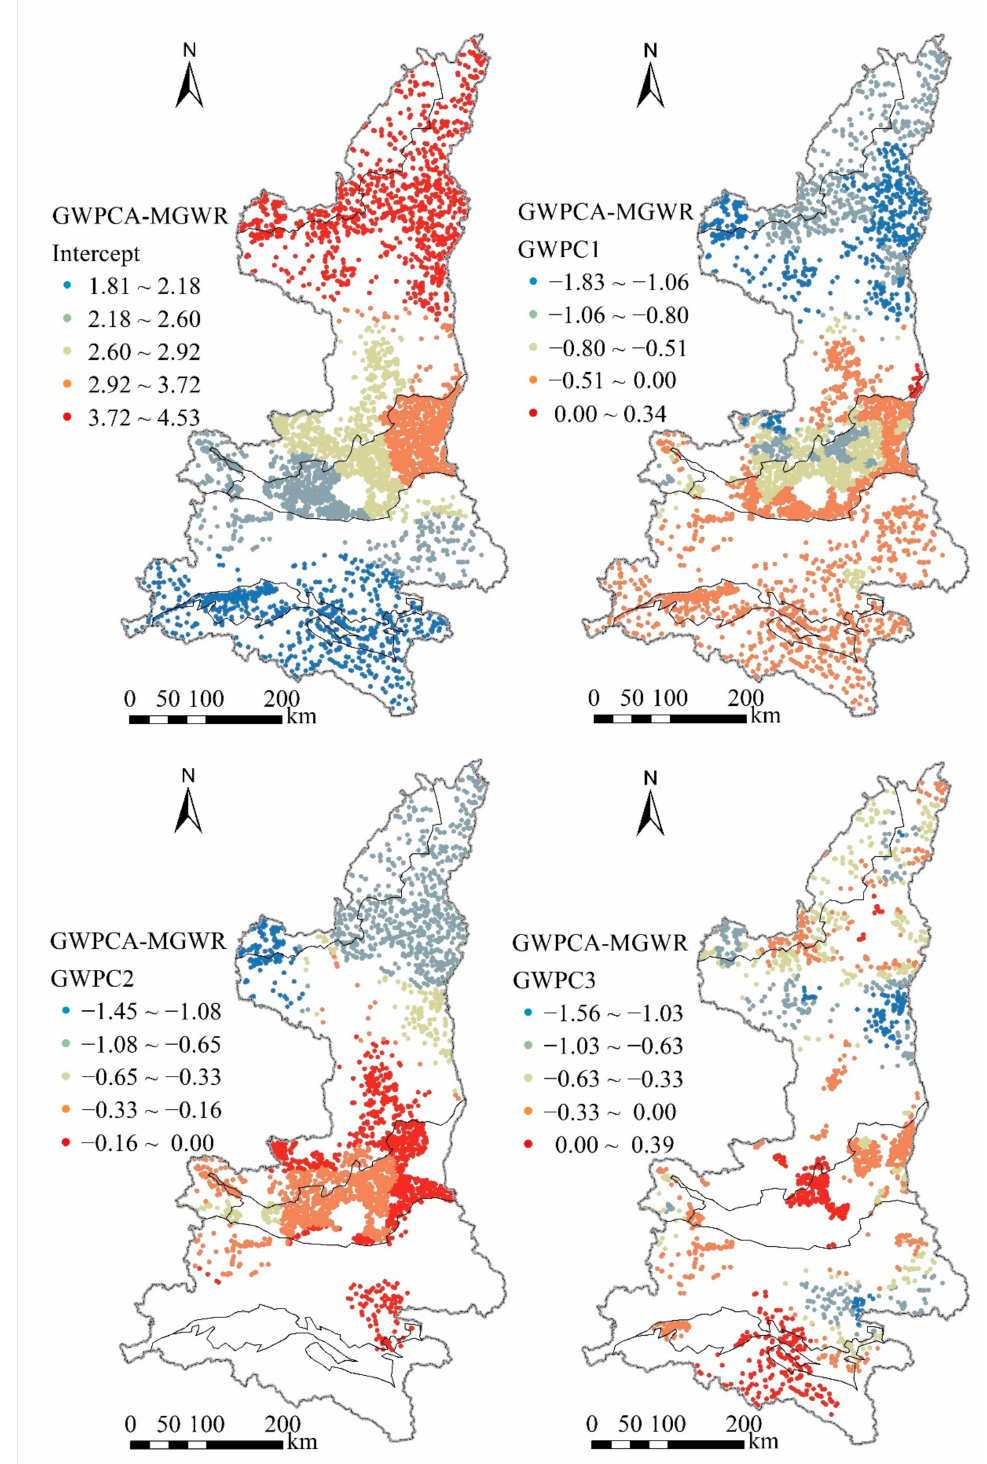
Figure 8. The spatial distribution of MGWR local coefficients (Significance level of